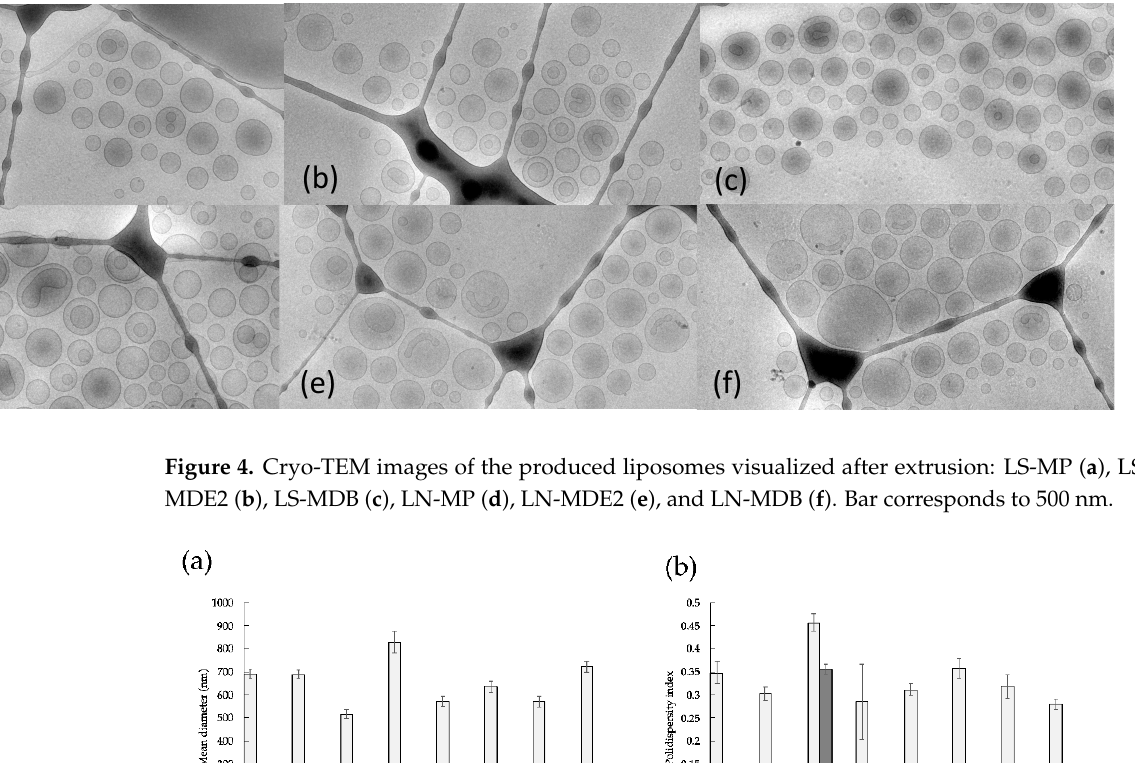
Figure 4. Cryo-TEM images of the produced liposomes visualized after extrusion: LS-MP ( a ), LS- MDE2 ( b ), LS-MDB ( c ), LN-MP ( d ), LN-MDE2 ( e ), and LN-MDB ( f ). Bar corresponds to 500 nm.